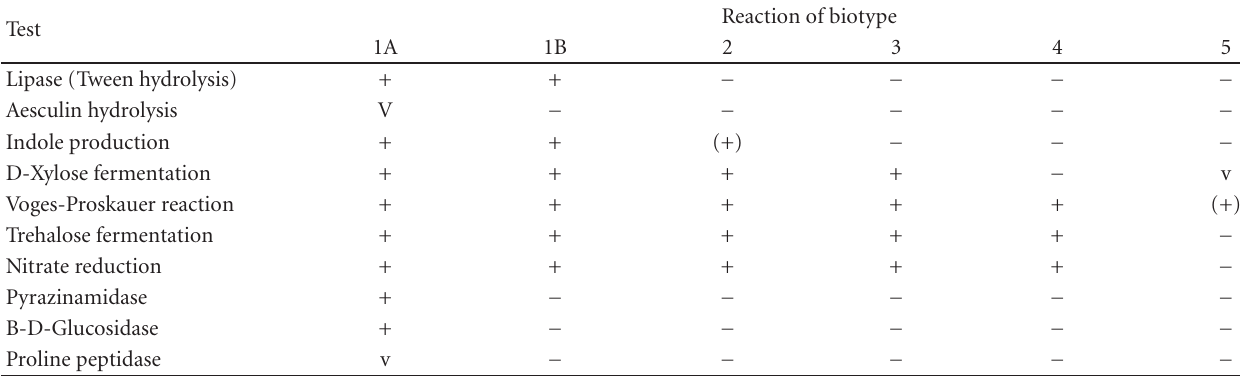
Table 1: Biotyping scheme of Y. enterocolitica (adapted from [33, 34]).